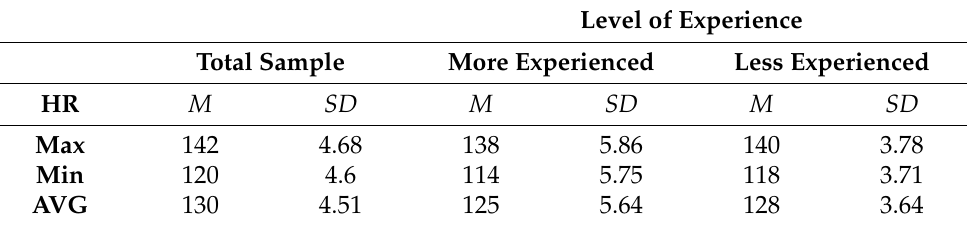
Table 1. HR (Max., Min. AVG) of the whole sample and according to level of experience.